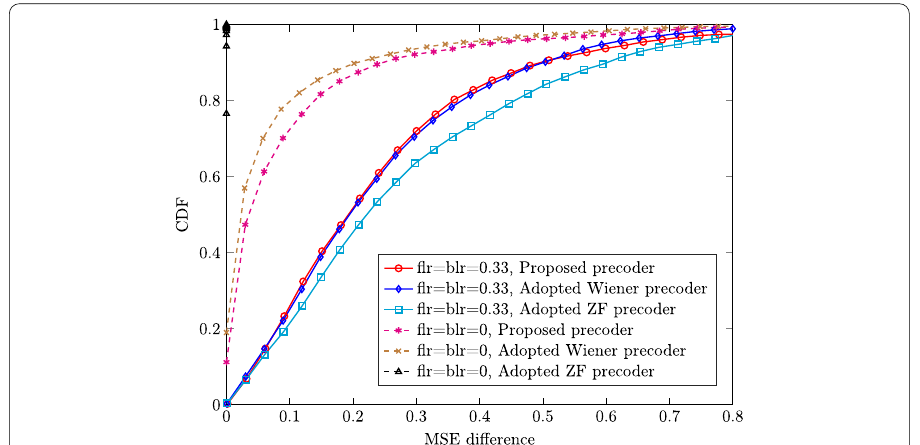
Fig. 8 CDF comparison of the proposed precoder with adopted ZF and Wiener precoders in terms of the users’ MSE difference in SFB-CBH ( r fl = r bl = 0.33 ) and FFB-FBH configurations and edge SNR of 10 dB . The channel is time-variant and N t = 1,N r = 1 , (cid:31) t = 1 ms and v = 5 km / h